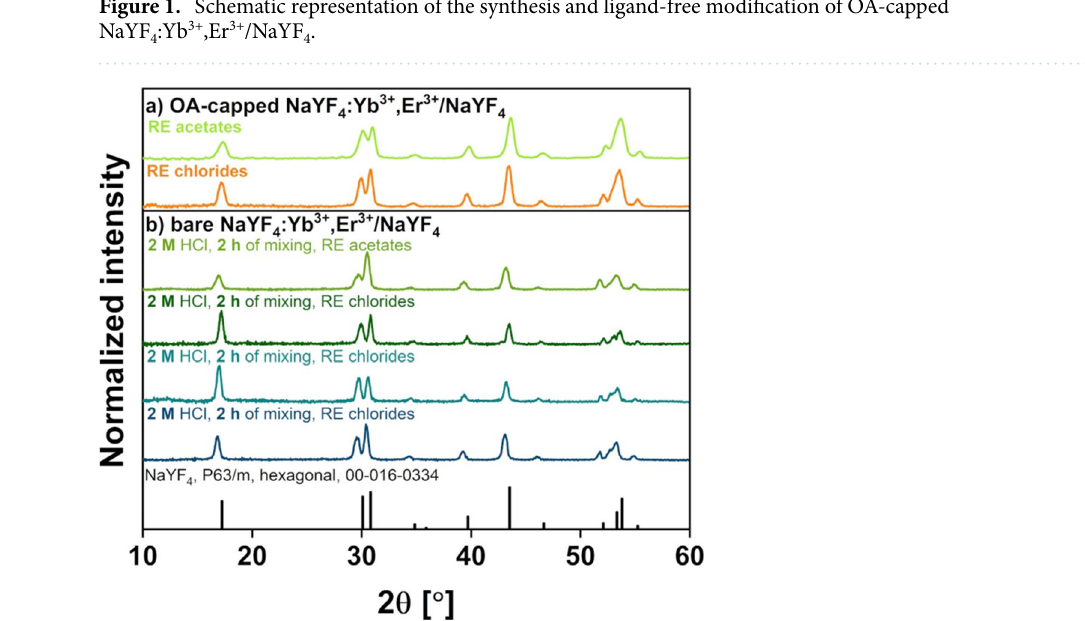
Figure 2. XRD patterns of ( a ) OA-capped and ( b ) ligand-free core/shell NaYF 4 :Yb 3+ ,Er 3+ /NaYF 4 UCNPs, and the XRD reference pattern from the JCPDS Database